Question: In one sentence, what is this figure communicating?
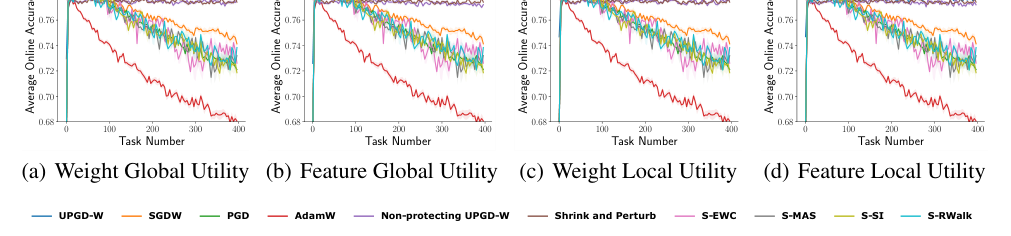
Answer: Performance of methods on Input-Permuted MNIST. First-order utility traces are used for UPGD and Non-protecting UPGD. Results are averaged over 10 runs.